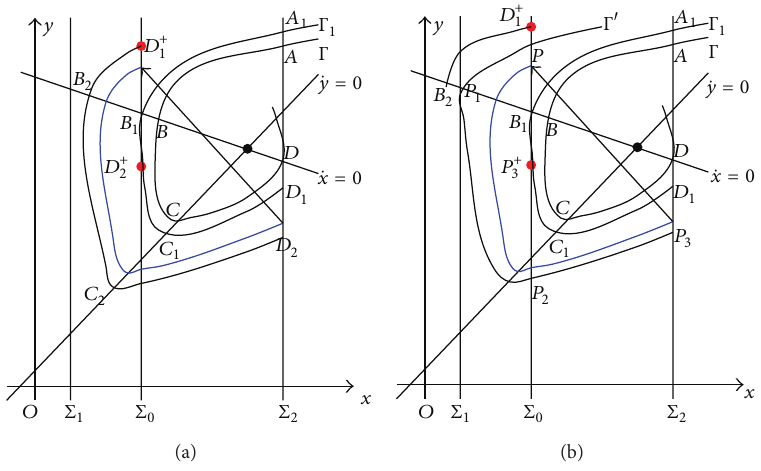
Figure 4: The possible trajectories in the case of ℎ 1 < (1 − 𝛼)ℎ 2 < 𝑥 𝐵 < 𝑥 ∗ < ℎ 2 .